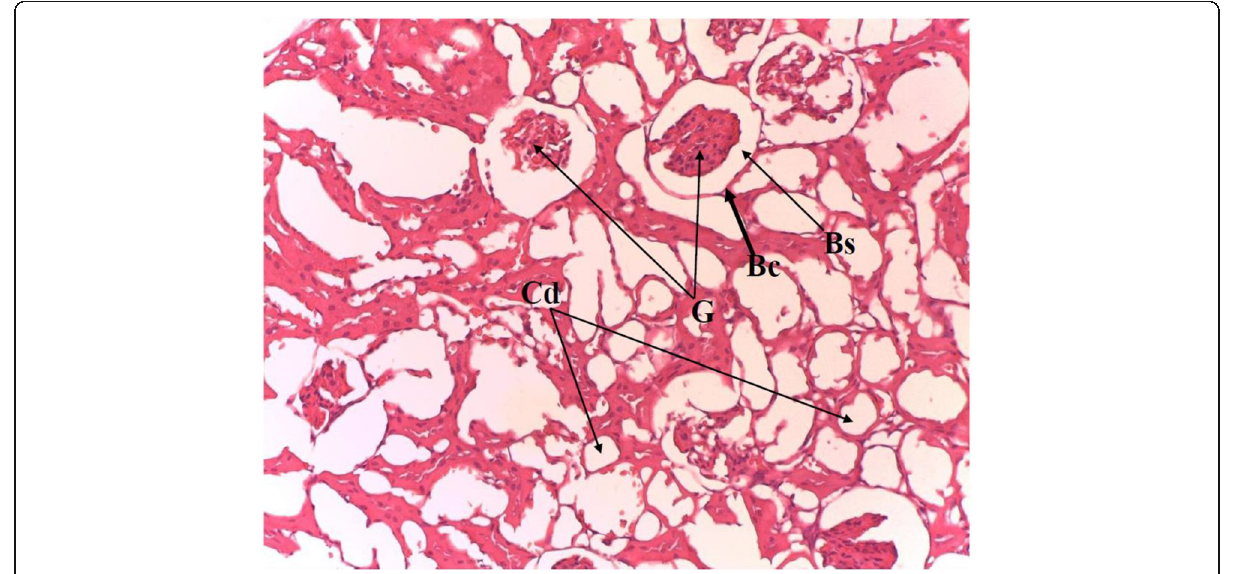
Fig. 9 Photomicrograph of kidney section of rats administered ethanolic seeds ’ extract of P. guineense (100 mg/kg bw) showing normal glomerulus (G), collecting ducts (Cd) and Bowman ’ s capsule (Bc). Some of the Bowman ’ s spaces (Bs) are mildly